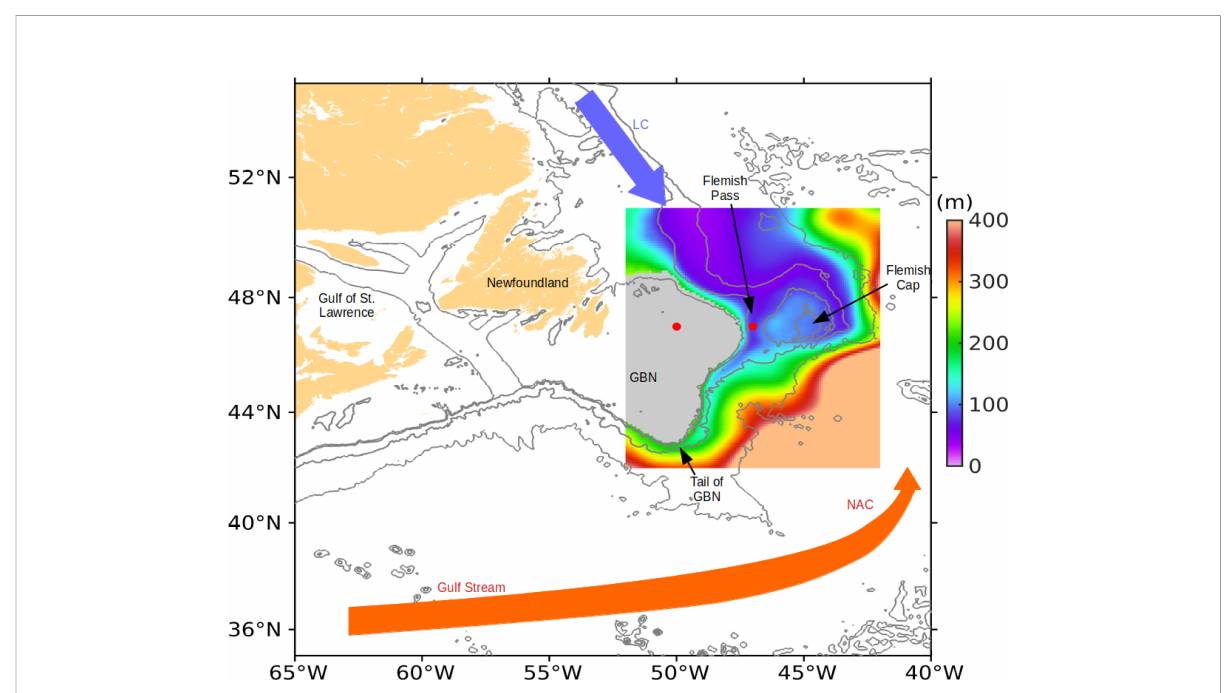
FIGURE 1 The western North Atlantic with the red and blue vectors denoting the direction of the North Atlantic Current (NAC) and Labrador Current (LC). The box outlines the Grand Banks of Newfoundland (GBN) and adjacent oceans. The color shading shows the depth of the isopycnal surface of 1027.25 kg/m 3 determined from the potential density averaged over 1993 - 2018. In grey shaded area, the maximum potential density is less than 1027.25 kg/m 3 . Black contours are isobaths of 200 m, 500 m, 2000 m and 4000 m. The two red dots at (50°W, 47°N) and (47°W, 47°N) are the positions for calculating the sea surface height differences shown in Figure